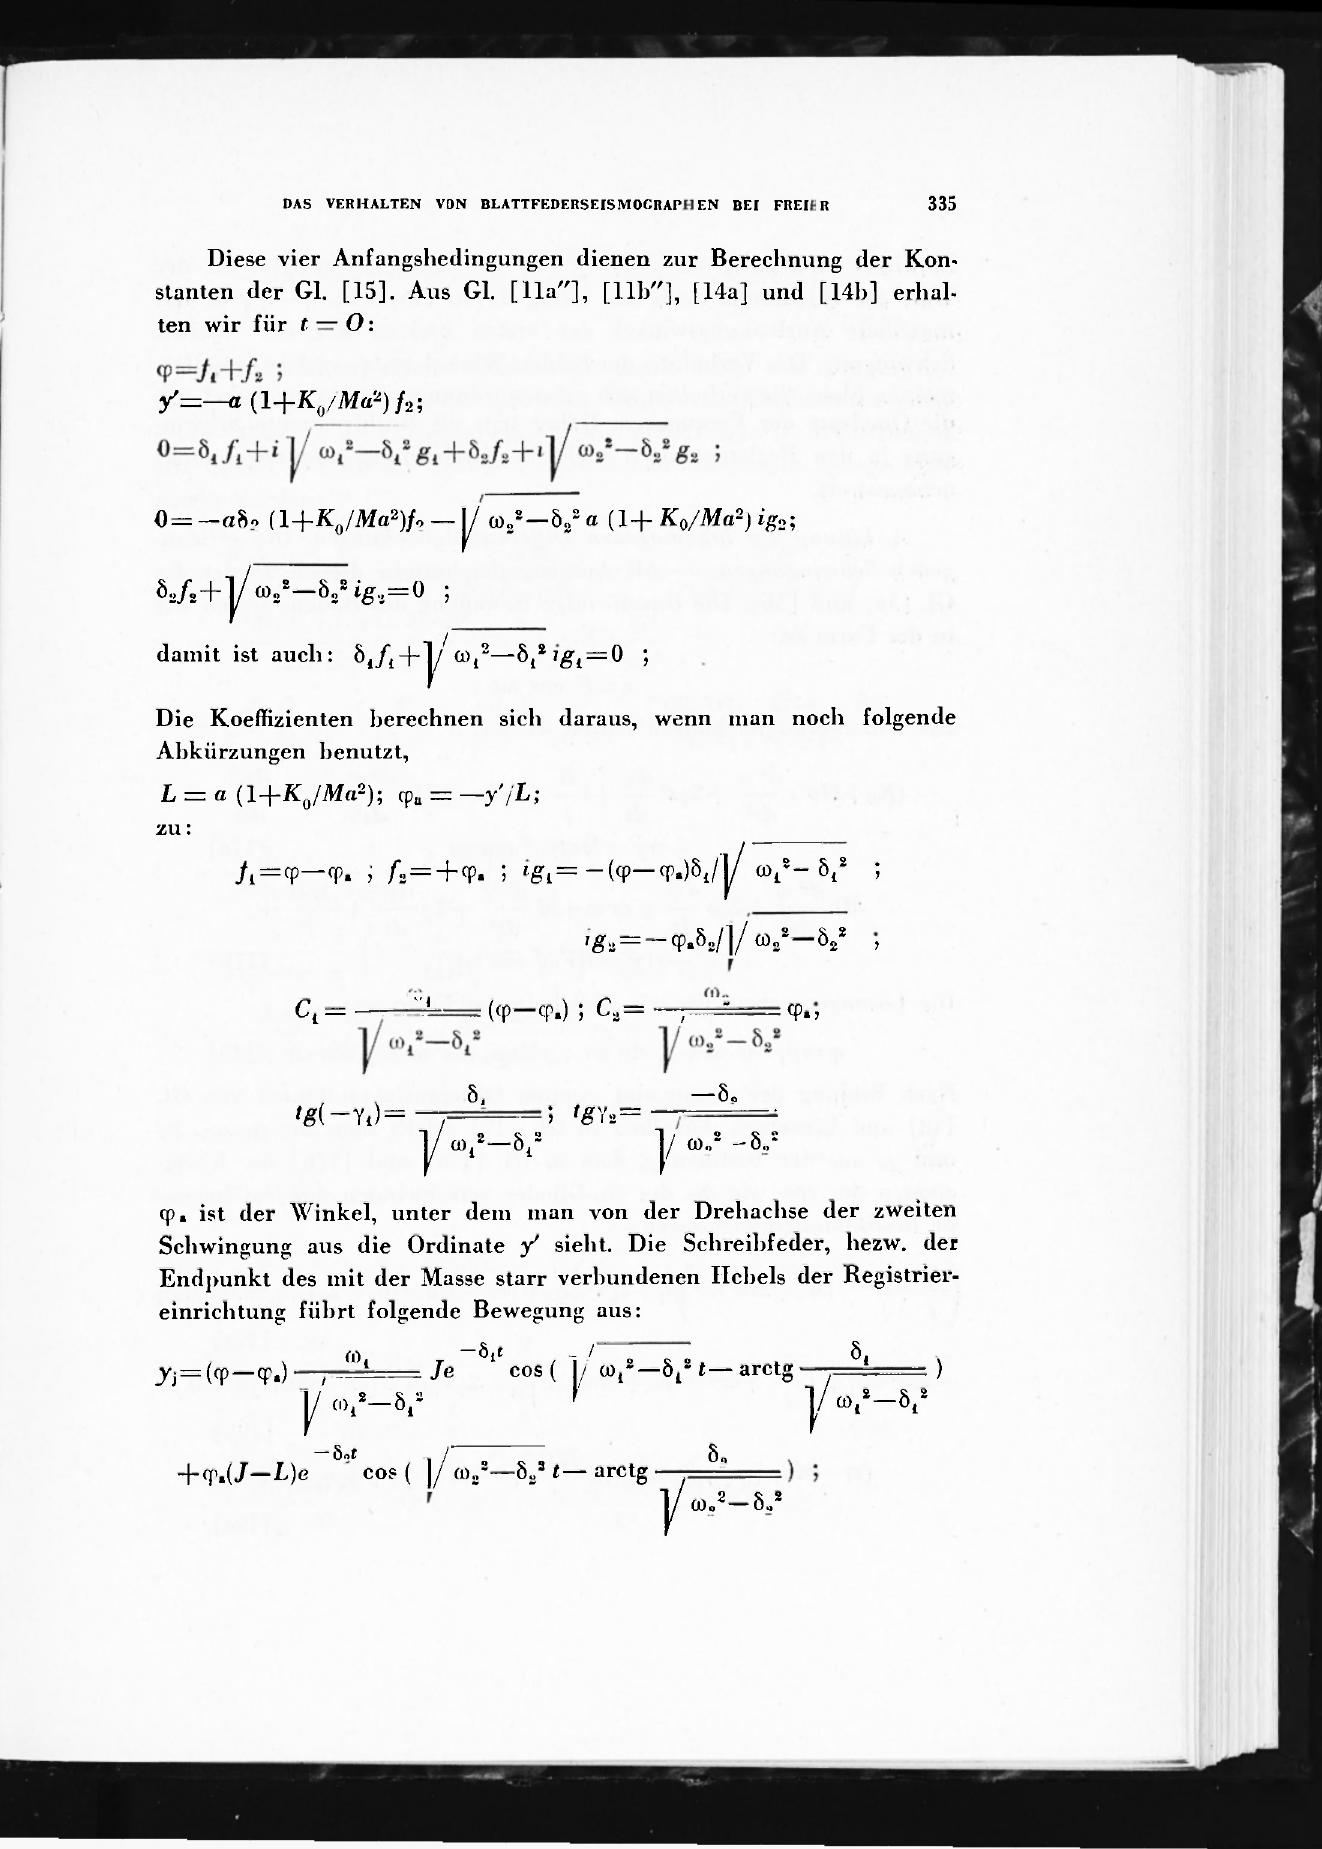
cp. ist der Winkel, unter dem man von der Drebaebse der zweiten Scbwingung aus die Ordinate / siebt. Die Scbreibfeder, bezw.